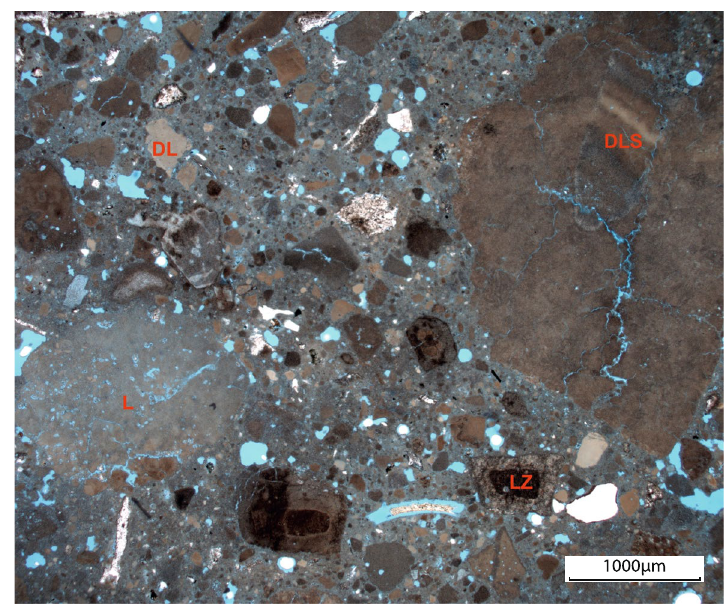
Fig. 18 Microscopic texture of the dolomitic lime mortar from Simatai Beijing showing dense texture in plane-polarised light (ppl). DLS: dolomite limestone relict in a lump of lime. DL: lump of magnesium rich lime. L: lump of lime. LZ: lump of lime inhomogeneous zoned (Source: Tanja Dettmering)